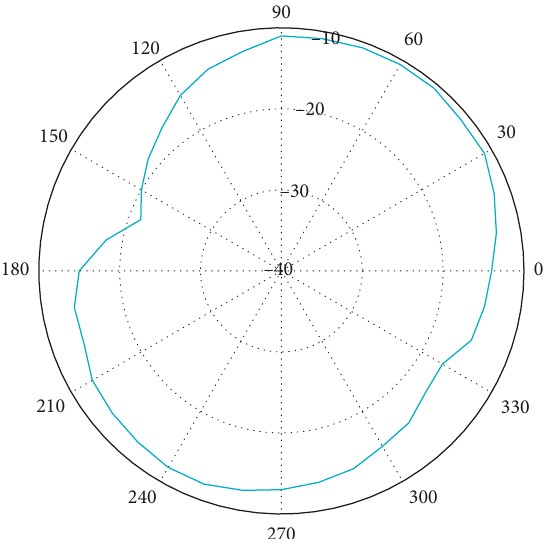
Figure 16: Emission diagram in vertical polarization in the 2 nd plane (dbm).